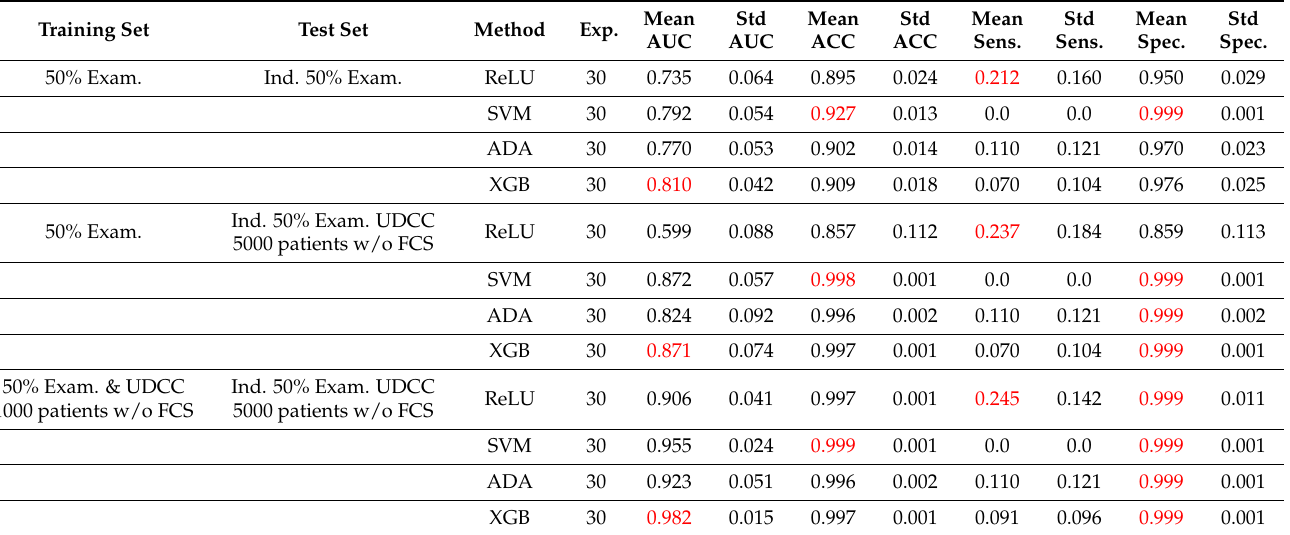
Table 2. Classification performance of models trained on